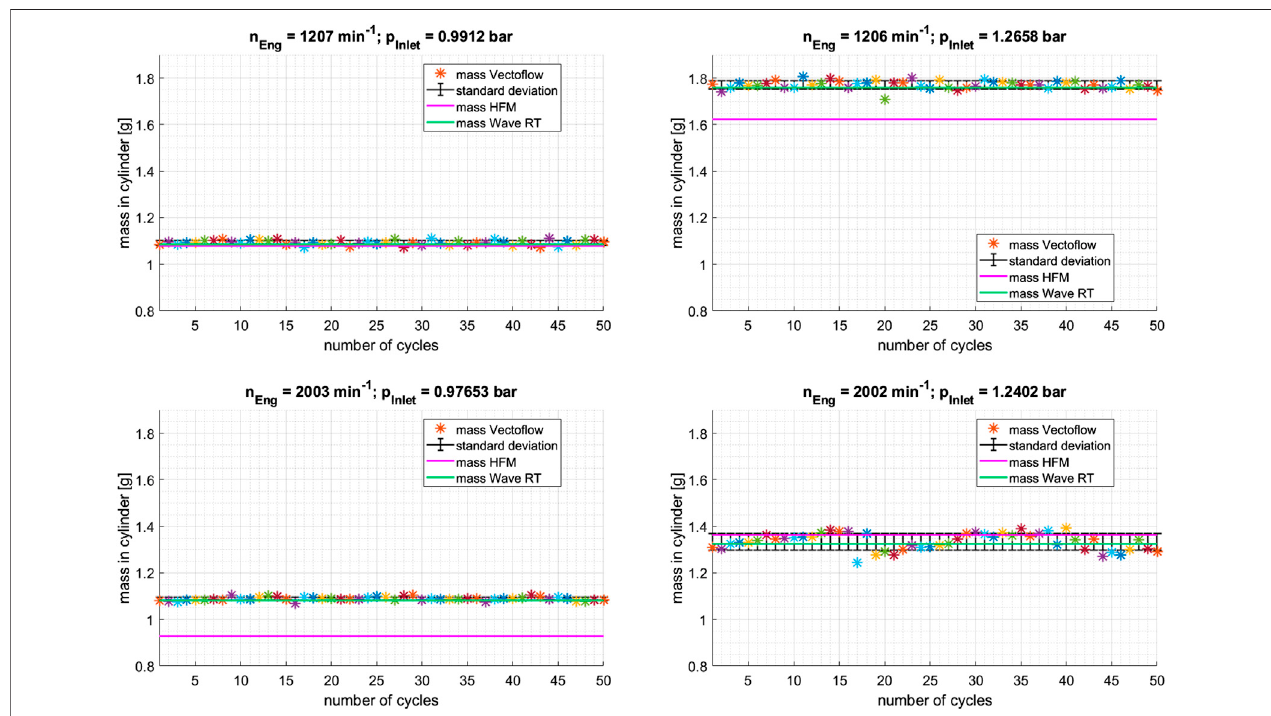
FIGURE 8 | Calculated mass in the cylinder per cycle and operating point. Conditions identical to Figure 4